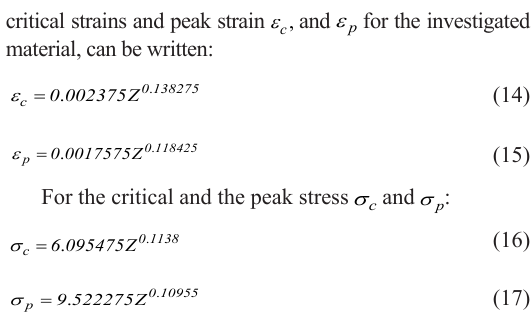
Figure 8. Plot of θσ vs. 2 σ employed to determine the slope m for the steel at different temperatures and strain rates.